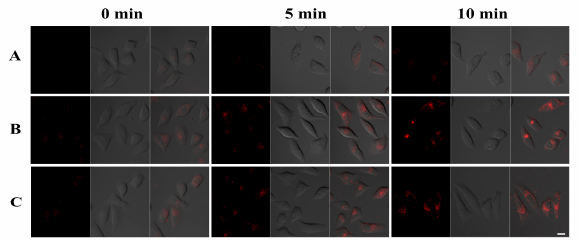
Figure 9. The red confocal microscopy images of HeLa cells treated with DAX-J2 (NO probe) ( A ) and DAX-J2 + Ru-Lbpy 1 ( B ) and DAX-J2 + Ru-Lbpy 2 ( C ) for 0, 5, 10 min by a light-emitting diode (LED) light (0.3 A, 420 nm). Excitation was performed with 561 nm laser and emission wavelength was recorded in the range of 579–701 nm. The scale bars: 20 µ